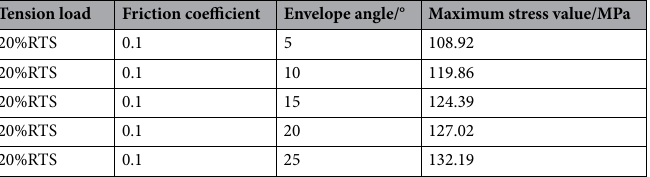
Table 2. Maximum equivalent stress of aluminum strand under different envelope angles.